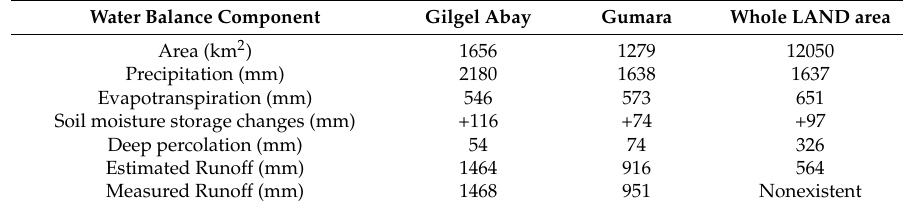
Table 1. The annual water balance components averaged over two gauged catchments (Gilgel Abay and Gumara) and the entire land areas of Lake Tana